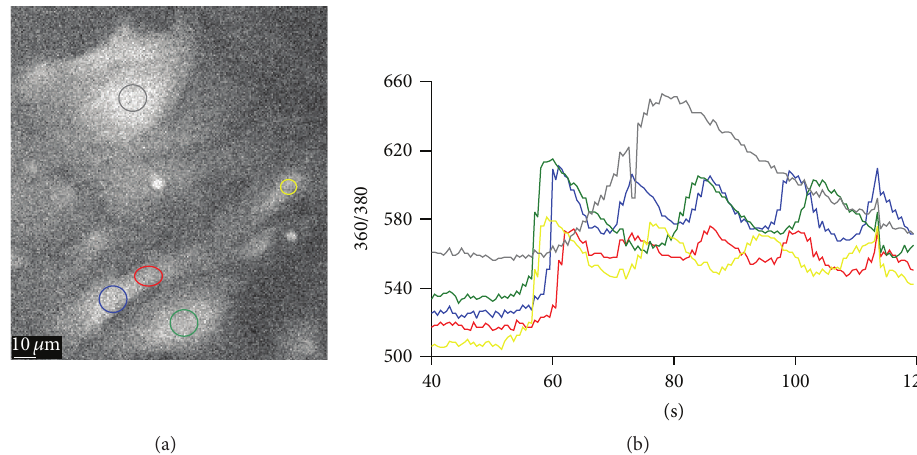
Figure 3: Calcium signaling upon agonist ACh stimulation of the aLC explant-cultured cells (a). The traces (b) represent the time courses and correspond to the regions of interest (ROI) shown on the B&W image (a) in the same of the 360 / 380 ratio (𝑅) , proportional to [ Ca 2+ ] i colors (explant growth time: 28